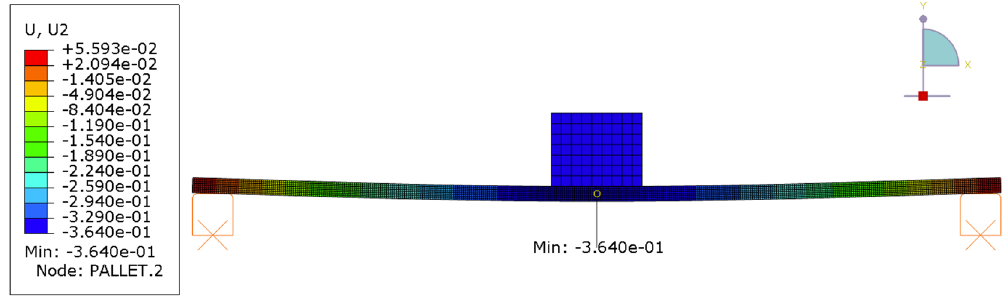
Figure 9. Two-dimensional FE model result for the simulated pallet segment and weight box, deformed. Figure values shown in inches.